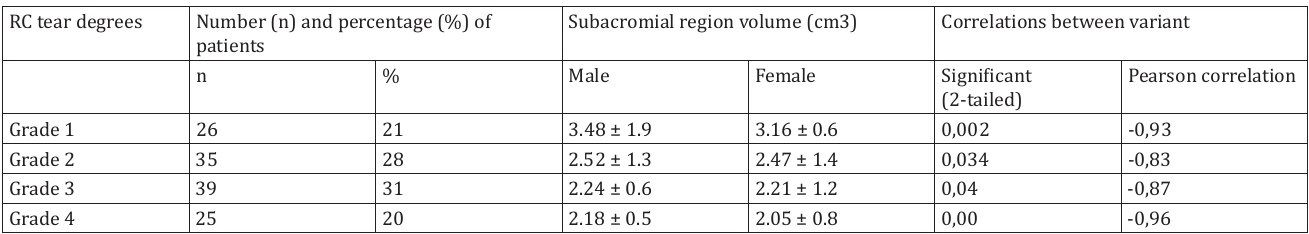
Distribution of rotator cuff (RC) injury and subacromial region volumes according to gender and degree of damage Table 2 with correlation matrix